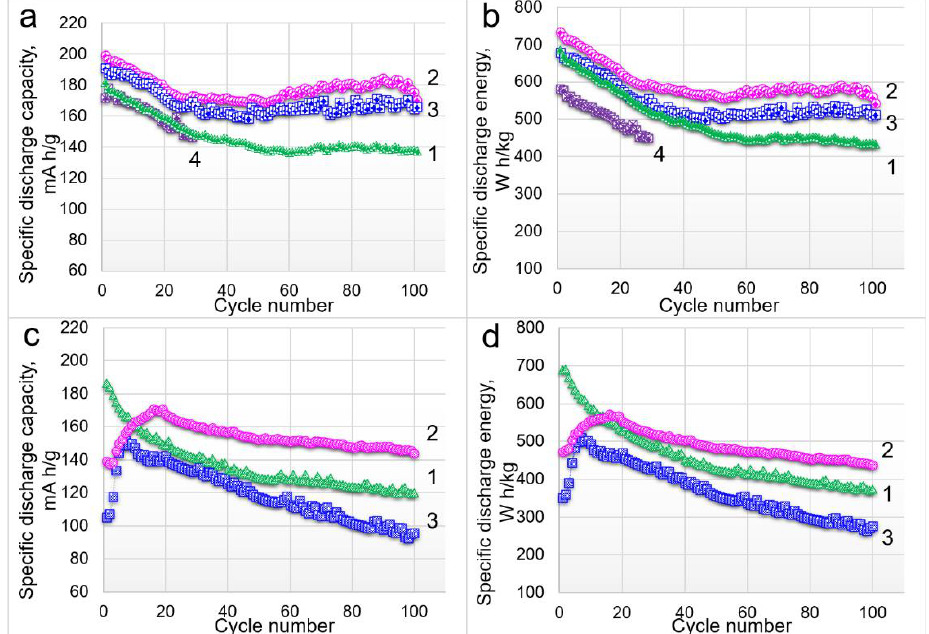
Figure 5. Cycling behavior of the cathode materials with different compositions cycled according to ( a , b ) protocol 1 and ( c , d ) protocol 3 at the current density of 80 mA/g. Designations: 1 — LMR20, 2 — LMR35, 3 — LMR50, and 4 — LMR65. The dQ/dV curves for the first, second, and 100th cycles for the materials without formation and the 100th cycle for the samples cycled by protocol 1 are shown in Figure 6.